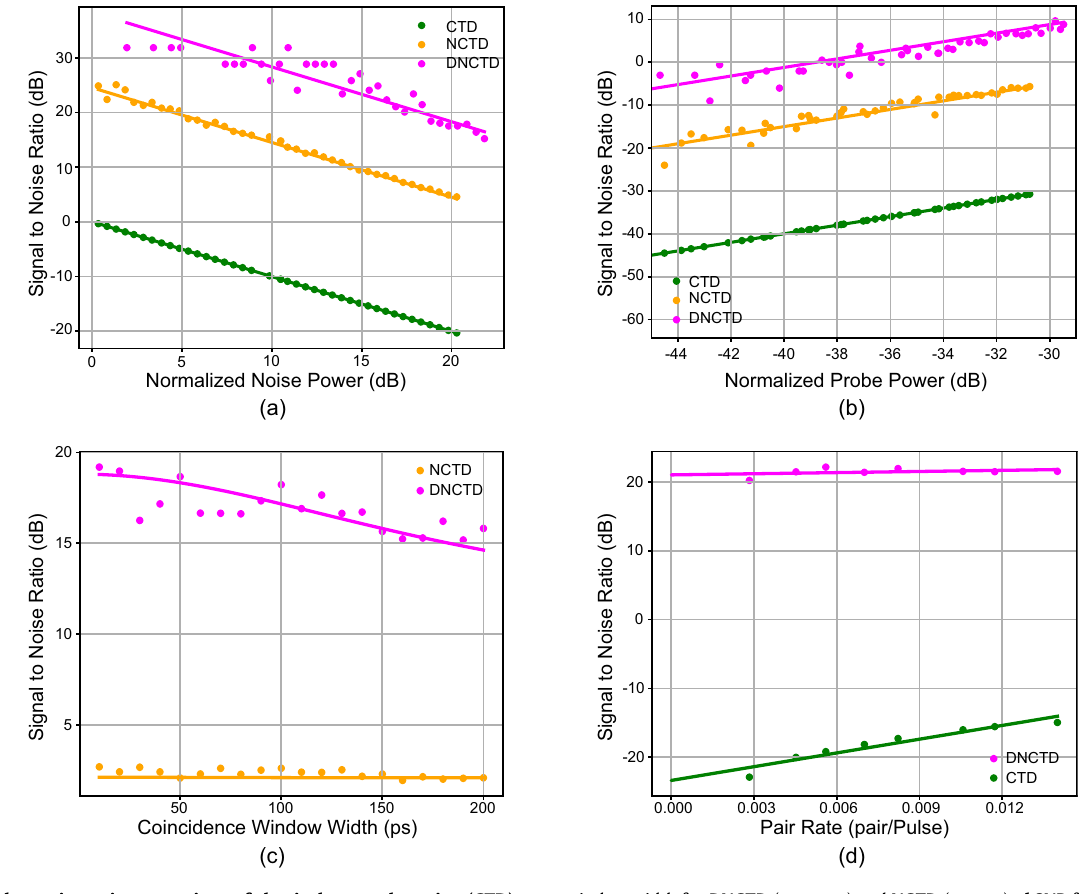
window width for DNCTD (magenta) and NCTD (orange). d SNR for DNCTD and CTD as a function of SPDC pair rate. The colored lines depict the theoretical pre- dictions for comparison with experimental